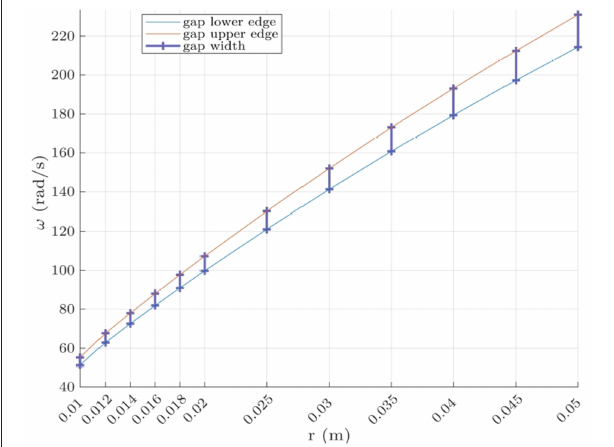
See also Figure 9 for a graphical representation of the Table.